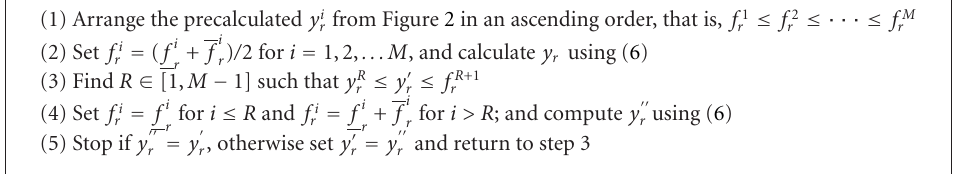
Algorithm 2: Iterative algorithm to compute y r